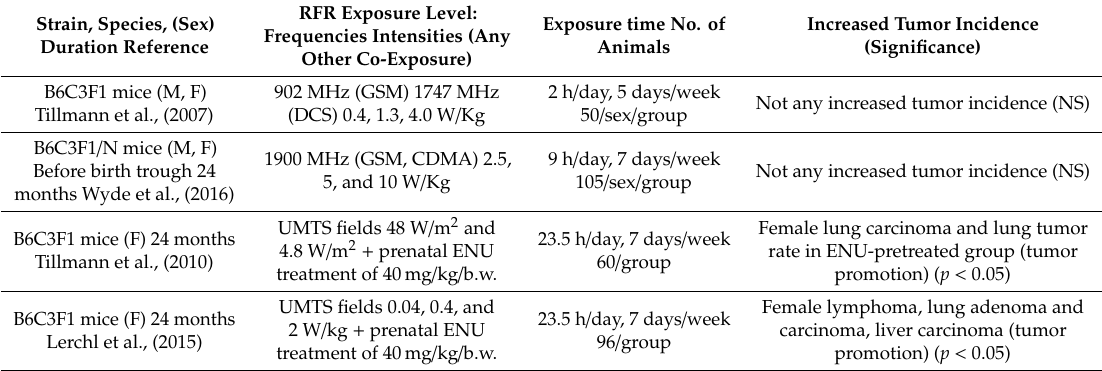
Table 2. Studies of carcinogenicity in mice exposed at least two years to